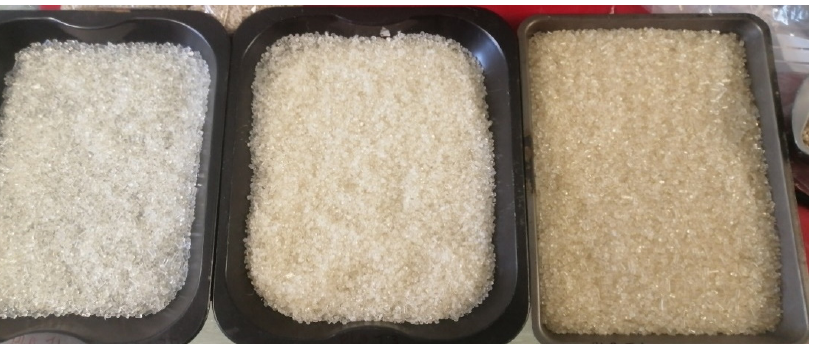
Figure 3. Granulated virgin PLA after recycling process; ( Left – Right ) 1 recycling, 3 recycling and 6 recycling steps.